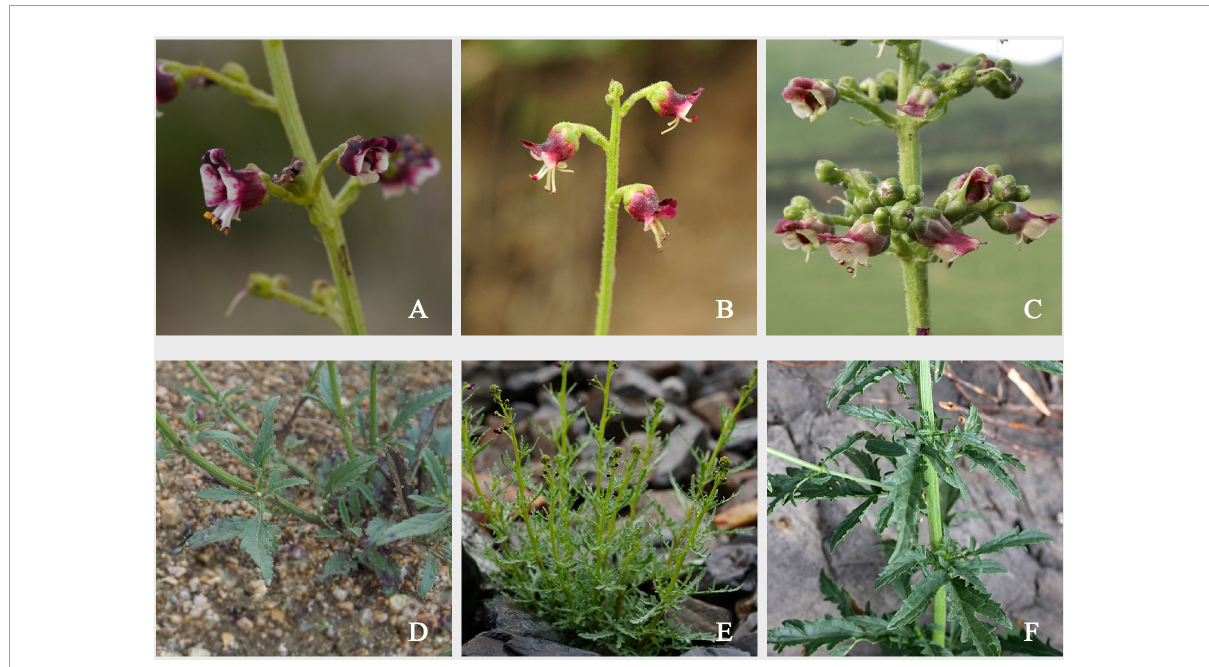
FIGURE1 Flower and leaves morphology of the three studied species. (A) Flower of S. incisa . (B) Flower of S. dentata . (C) Flower of S. kiriloviana . (D) Leaves of S. incisa . (E) Leaves of S. dentata . (F) Leaves of S. kiriloviana . Photo A by Ye-Chun Xu; B by Jun Liu; C,F by Xue-Jing Zhan; D,E by Guo-Jun Hua.